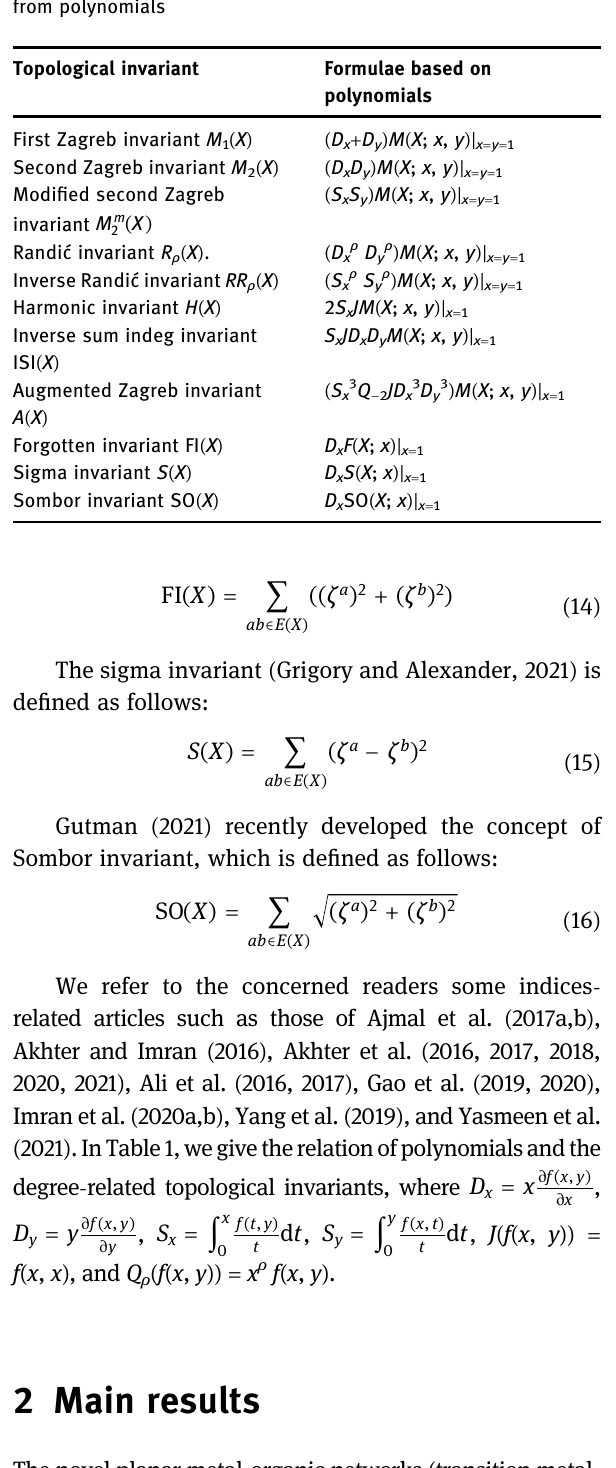
Table 1: Derivation of some degree - related topological invariants from polynomials